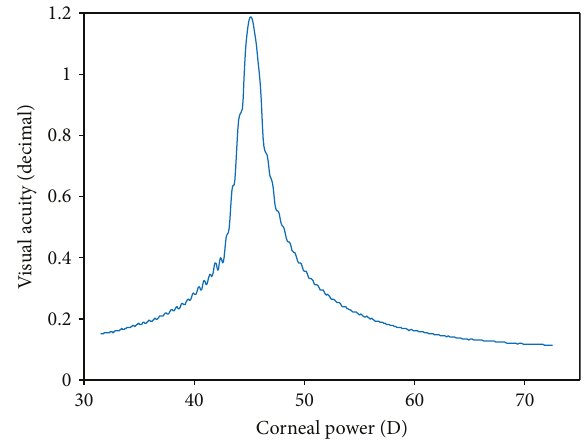
Figure 1: Axial visual quality versus corneal power. The peak is taken as the OCP.